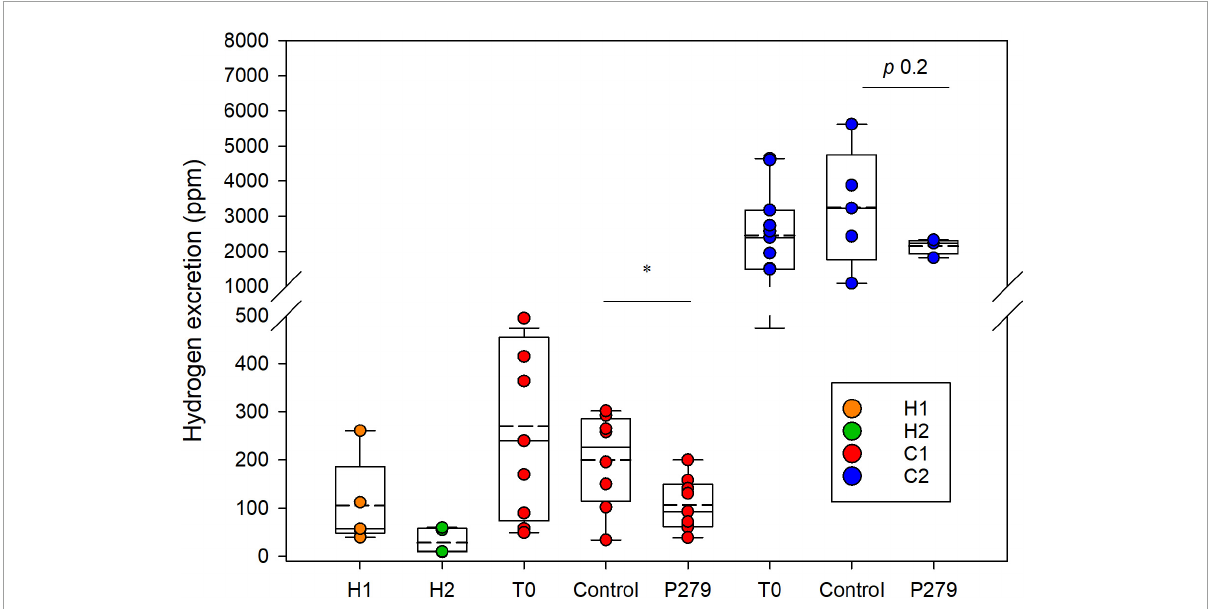
FIGURE3 Hydrogen excretion by IMA rats. Hydrogen concentration (ppm) accumulated in the respiratory chambers after 24 h of housing single IMA rats. Measurements were done at the end of experimentation for rats inoculated with feces from healthy donors (H1 and H2) and at baseline (T0) and after intervention for rats inoculated with feces from colic donors (C1 and C2). Treatment groups (P279) were gavaged daily for 12–15 days with 10 9 CFU of Cutibacterium avidum P279 in 350 µ L of sterile skim milk, and control groups received daily 350 µ L of sterile skim milk. Values are mean (H1 n = 5; H2 n = 5; C1 T0 n = 9; C1 P279 n = 9; C1 control n = 8; C2 T0 n = 11; C2 P279 n = 4; and C2 control n = 5). Central horizontal solid lines show the median and dashed lines the mean, upper and lower box borders show the 90th and 10th centiles, respectively, and upper and lower whiskers show the 95th and 5th centiles, respectively.